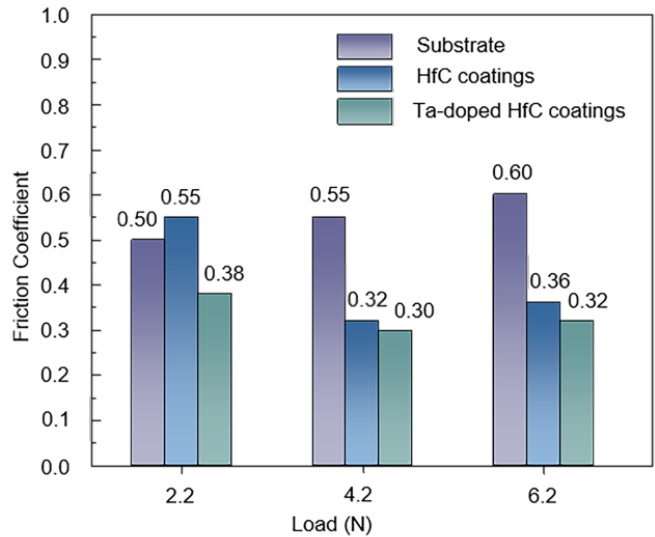
Figure 10. The friction coefficients of coatings and the substrate.